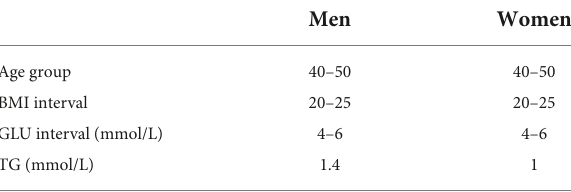
TABLE 4 Transition points for age, BMI, GLU, and TG in terms of the risk of high SBP.